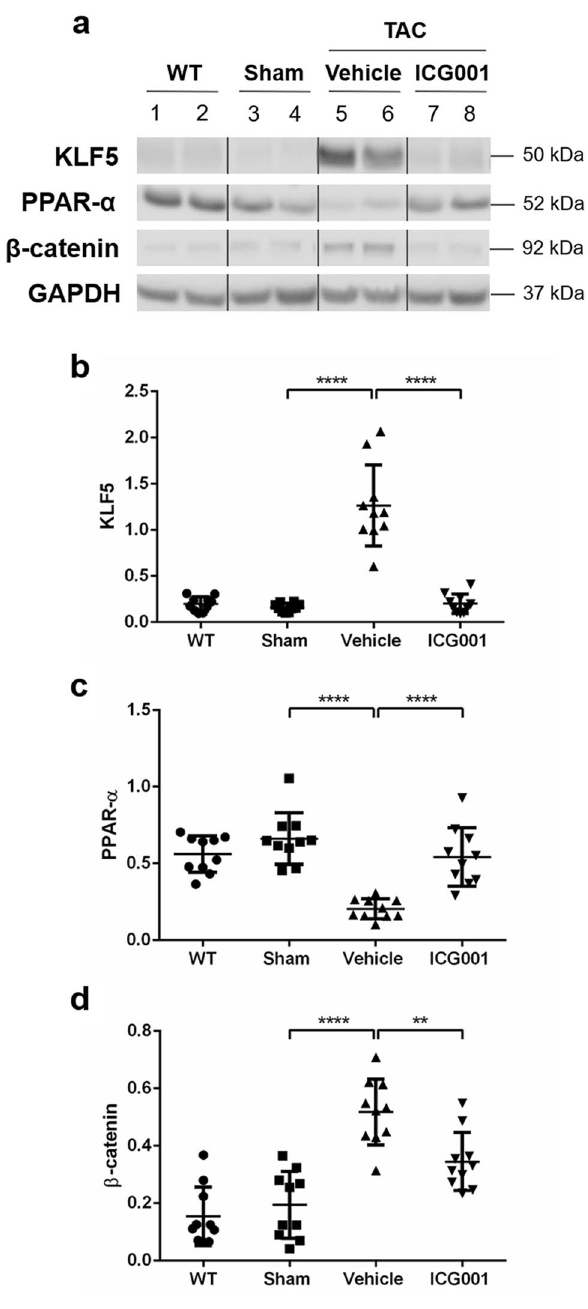
Figure 3. ICG001 induced gene and protein expression of cardiac hypertrophy and fibrosis after TAC. ( a ) Western blot analyses showed the protein expression of KLF5, PPAR-α, and β-catenin in the heart of mice from various groups, as indicated. GAPDH was used as a loading control. ( b–d ) Quantitative data of the protein levels of KLF5, PPAR-α, and β-catenin are presented in various groups, as indicated (n = 10). The vertical lines indicate the grouping of cropped images. Statistical significance of distributed data was analyzed by one-way ANOVA followed by Tukey’s multiple comparisons test. **** P < 0.0001, ** P < 0.01 vs. vehicle